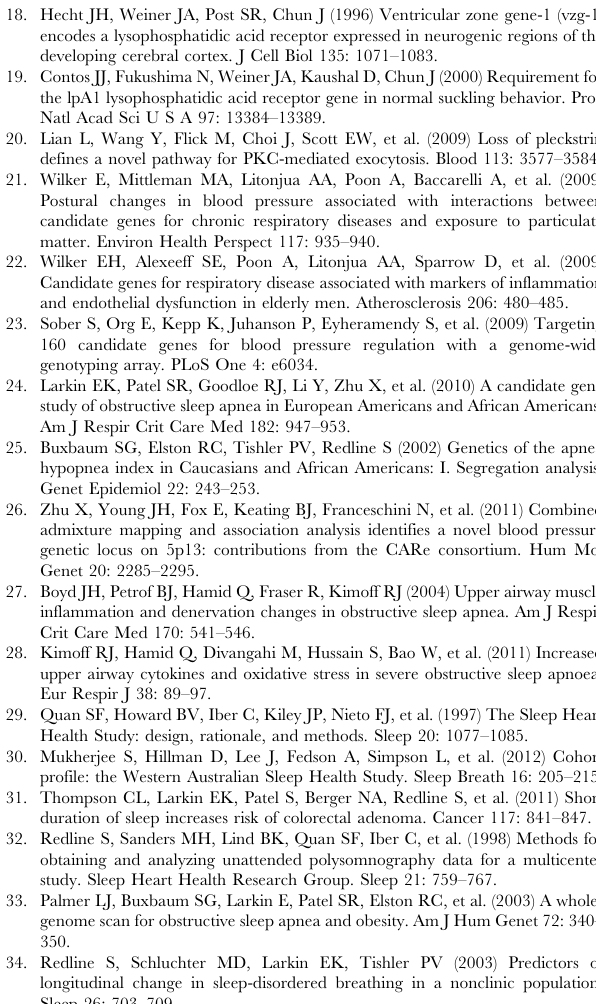
respectively adjusting for age, sex, and BMI and one-sided p- values were computed. Figure S1 Quantile-quantile plot for apnea hypopnea index in African-Americans. This figure plots expected versus observed p- values from the association analyses of all SNPs against log(apnea hypopnea index + 1) in African-Americans. The plotted observed p- values are after accounting for genomic control. Figure S2 Quantile-quantile plot for obstructive sleep apnea in African-Americans. This figure plots expected versus observed p- values from the association analyses of all SNPs against an apnea hypopnea index of 15 or greater in African-Americans. The plotted observed p-values are after accounting for genomic control. Figure S3 Quantile-quantile plot for apnea hypopnea index in European ancestry individuals. This figure plots expected versus observed p-values from the association analyses of all SNPs against log(apnea hypopnea index + 1) in those of European ancestry. The